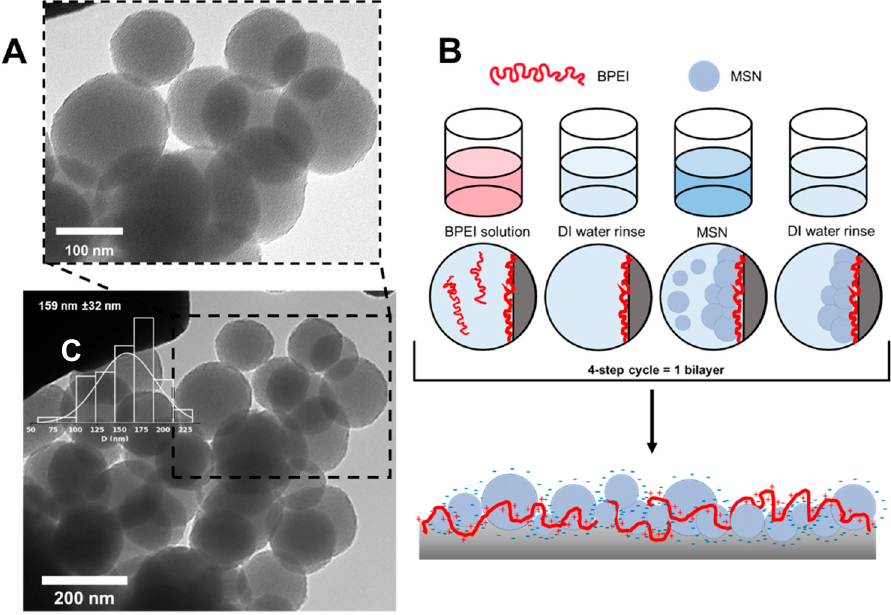
Figure 2. Transmission scanning microscopy (TEM) images for MSNs ( A ) and schematic illustration of deposition of a 1-BL coating using the layer-by-layer (LbL) technique ( B ). The histogram graph within the TEM image was generated via analyzing 200 nanoparticles in several TEM images using imageJ software ( C ).